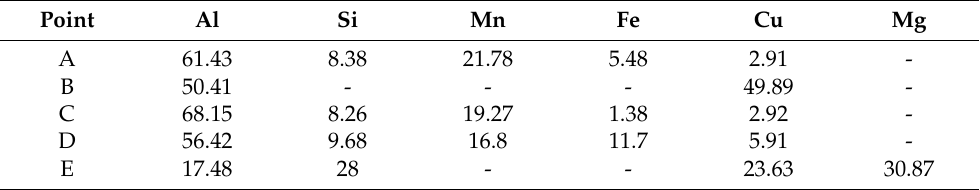
Figure 6. ( a – c ) Bright-field TEM micrographs; ( d – h ) EDS spectra of phases indicated in ( a – c ). ( A – E ) are the different phases in Figure 6 ( a – c ). Table 3. Energy spectrum analysis of grain boundary phase composition (wt.%) from Figure